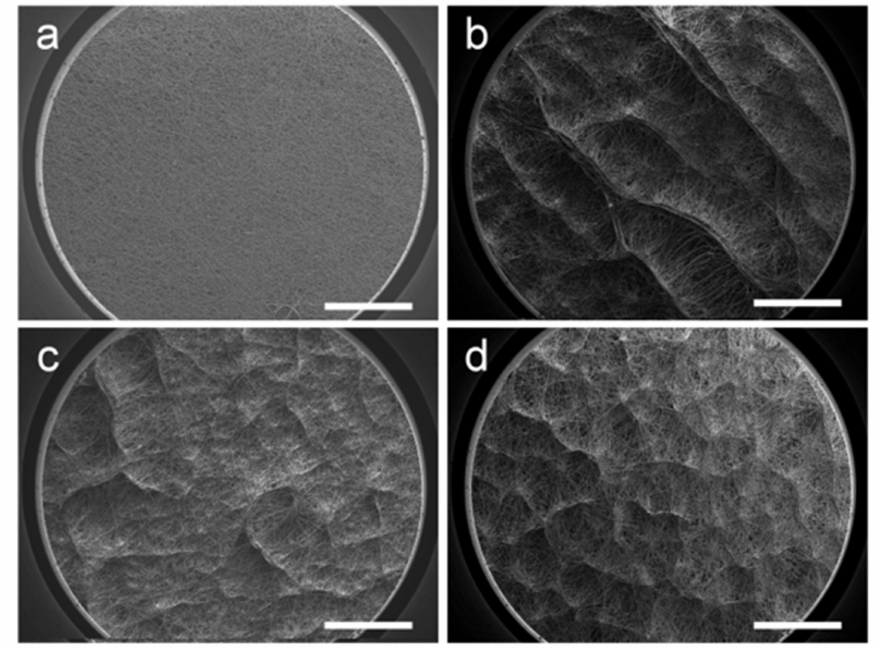
Figure 3. SEM images of e-spun films at different receiving temperatures—( a ) 23 ◦ C, ( b ) 0 ◦ C, ( c ) − 10 ◦ C and ( d ) − 20 ◦ C—at a humidity of 50%. Scale bars are 1